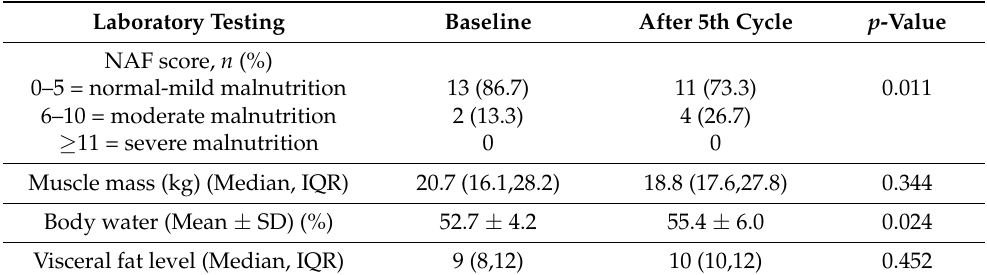
Table 3. Nutritional status and anthropometric measurements before 1st cycle and after 5th cycle of